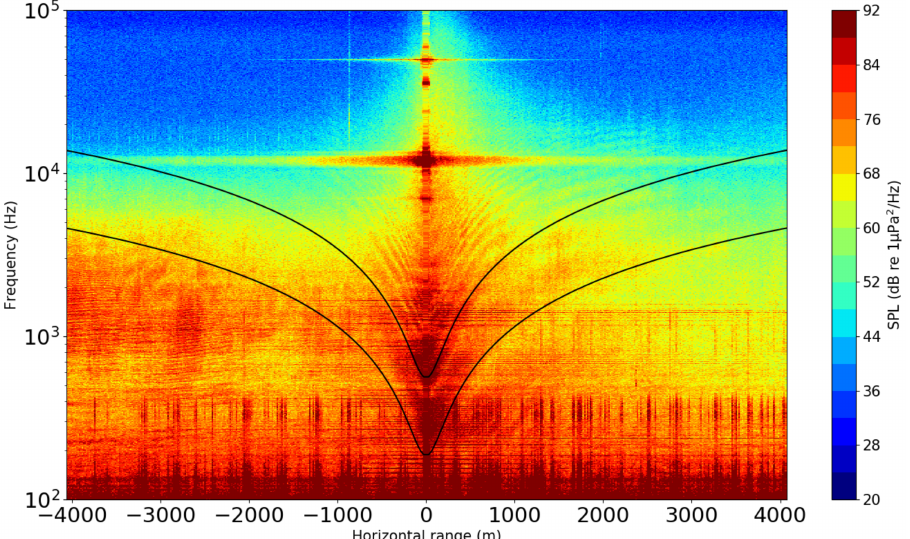
Figure 3. Spectrograms relative to the location of the PAM mooring for a transit of the CCGS Vector at a constant speed at 1500 RPM. The first two Lloyd’s mirror effect peaks are highlighted with black lines. The vessel is travelling from left to